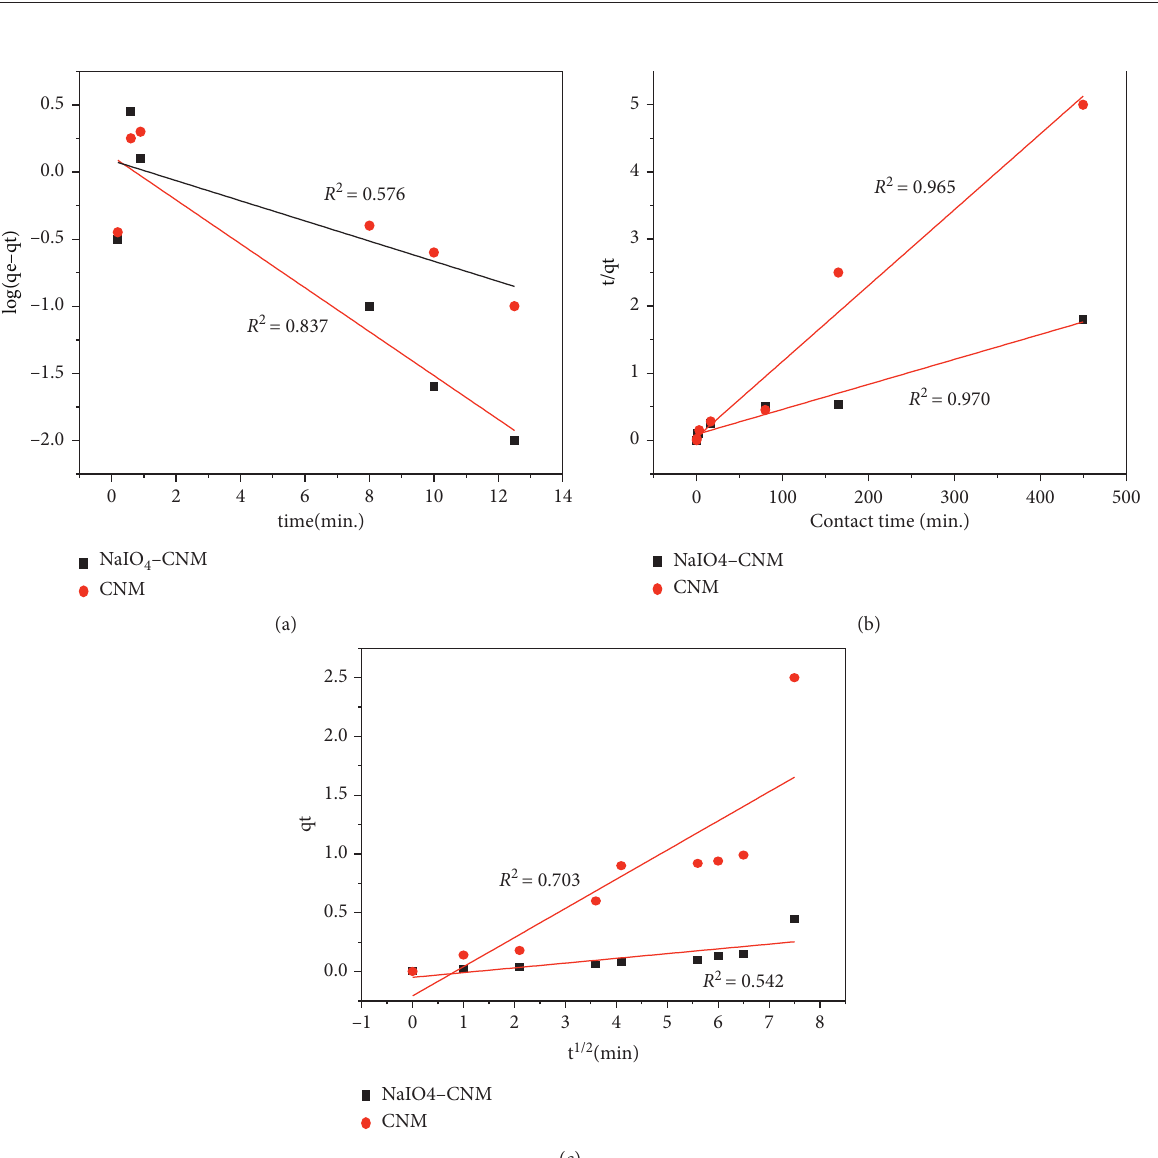
Figure 8: Plot of the PFO (a), PSO (b), and intraparticle diffusion (c) model at Co � 30mg/L, pH � 6, adsorbent dose � 1 (g), contact time � 120min, and agitation speed � 250 rpm for Pb(II) ions and Ni(II) ions removal,